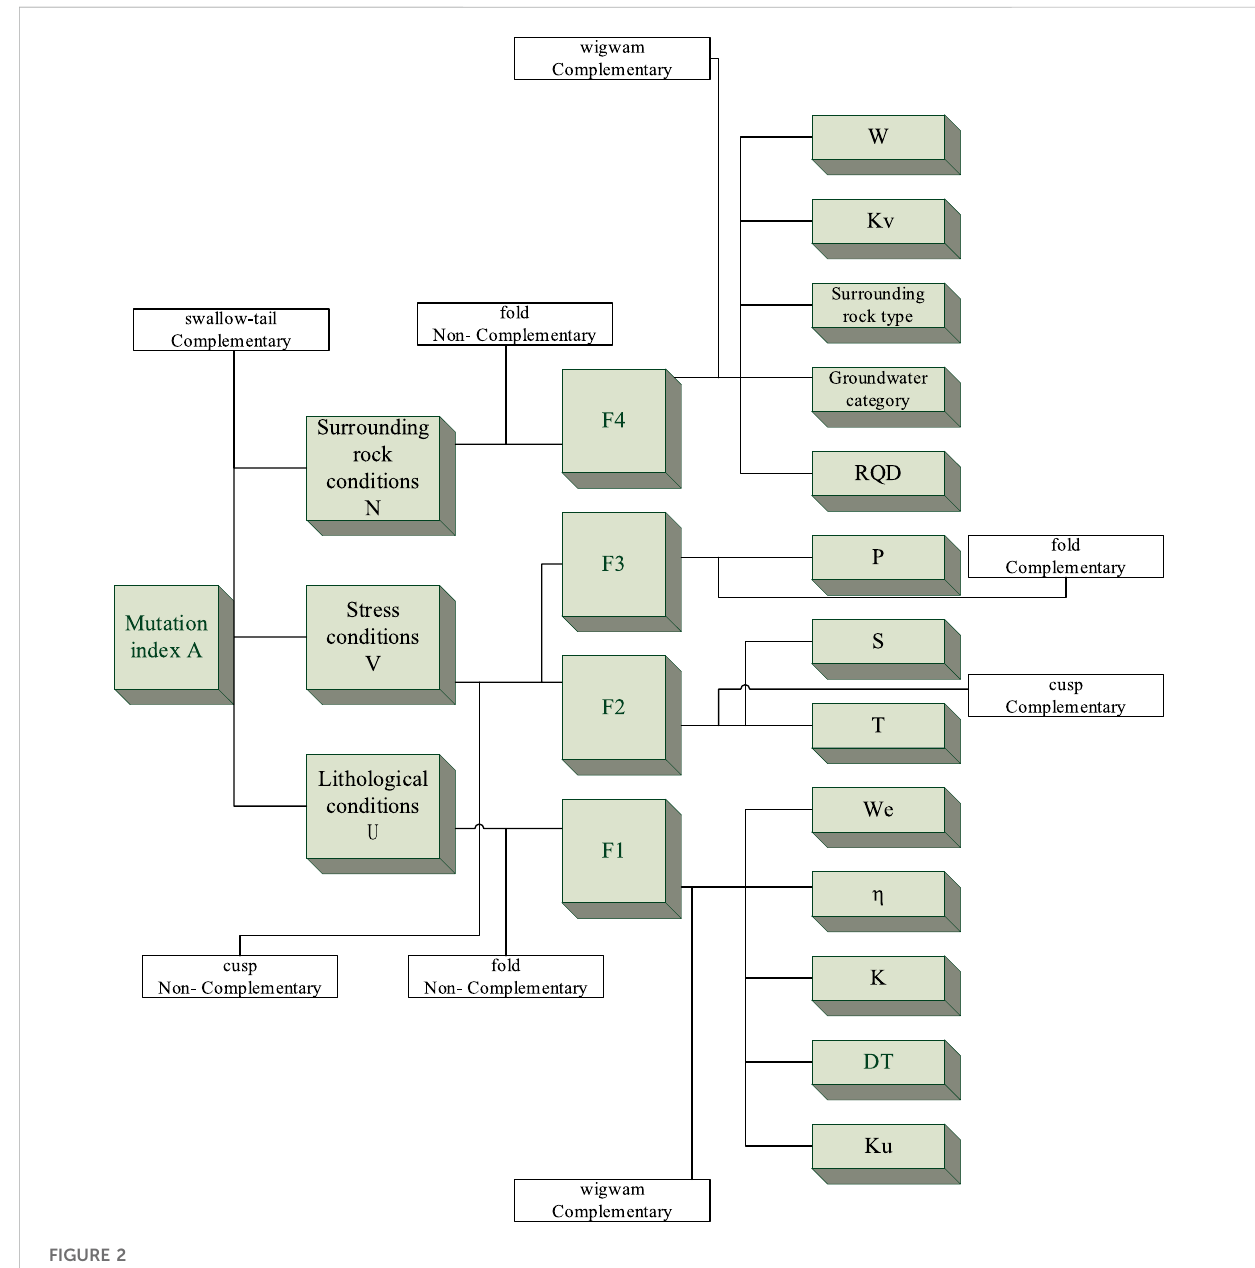
FIGURE 2 Rockburst evaluation system of the principal component analysis – catastrophe progression